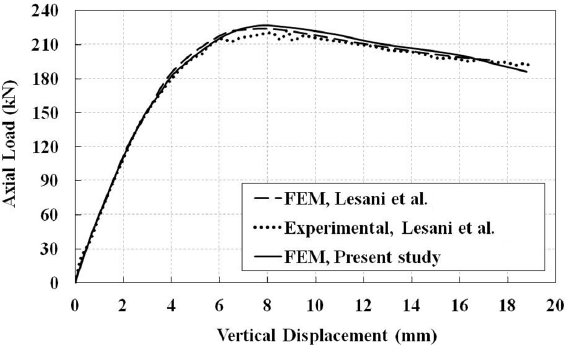
Figure 4. Comparison of the numerical method used in this study with Lesani et al. [10].